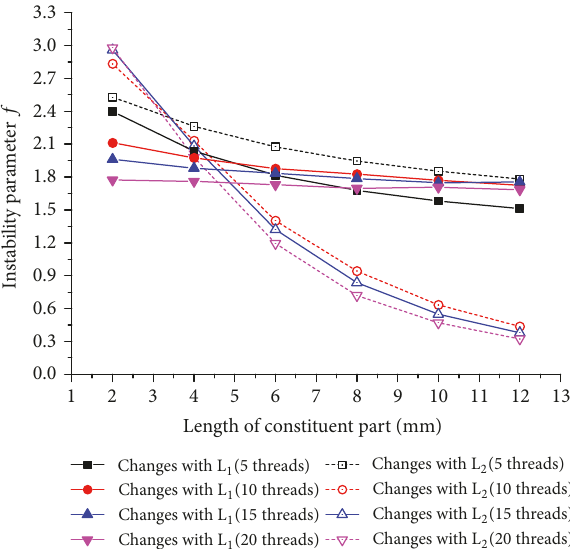
Figure 11: Instability parameter f changes versus L 1 and L 2